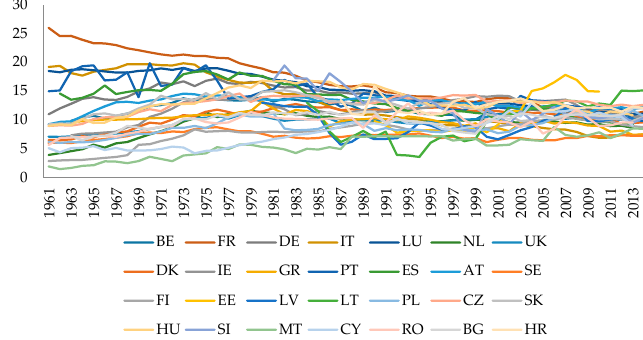
Figure 1. Per-capita alcohol consumption in the European Union (1961–2014), liters of pure alcohol (LPA). Dispersion of per-capita consumption clearly receded over the last 50 years. The only deviations from the overall pattern can be observed for the Baltic countries, Estonia and Latvia. Most of the conversion seems to be driven by the countries with initially high alcohol intake—France, Italy, Portugal, Luxembourg and Spain. Countries with moderate per-capita consumption did not change much of their alcohol intake in absolute terms, while countries with initially low per-capita consumption (Malta, Finland and Cyprus) converged upwards. Table 2 shows more detailed information on the overall alcohol consumption and confirms that it did not decrease due to newcomers (which entered the political map and the database later). On the one hand, the mean and the maximum values of alcohol consumption in 2010 are considerably lower than those of the year 1970. On the other hand, the minimum level of alcohol consumption has also increased—from less than 4 liters in 1970 to 6 liters in 2010. In the 1980s both the mean and the median alcohol consumption across European countries were at their highest—at the value of about 13 liters, and the 2000s was the decade with smallest per-capita numbers—only about 10 liters. Standard measures of dispersion (standard deviation, STD, and coefficient of variation, CV) also suggest a reduction in the variation of alcohol consumption across European countries. Furthermore, the absolute distance from the mean and the median clearly decline with time, suggesting that the consumption patterns smooth out across European countries. If we calculated changes in these convergence parameters on the decade-to-decade basis, it would become clear that the process of convergence started long ago and the changes cumulated over time, resulting in the drastic difference between the situation of today and some 40–50 years ago. Table 2. Alcohol consumption in the EU: levels, descriptive statistics and dispersion. Country